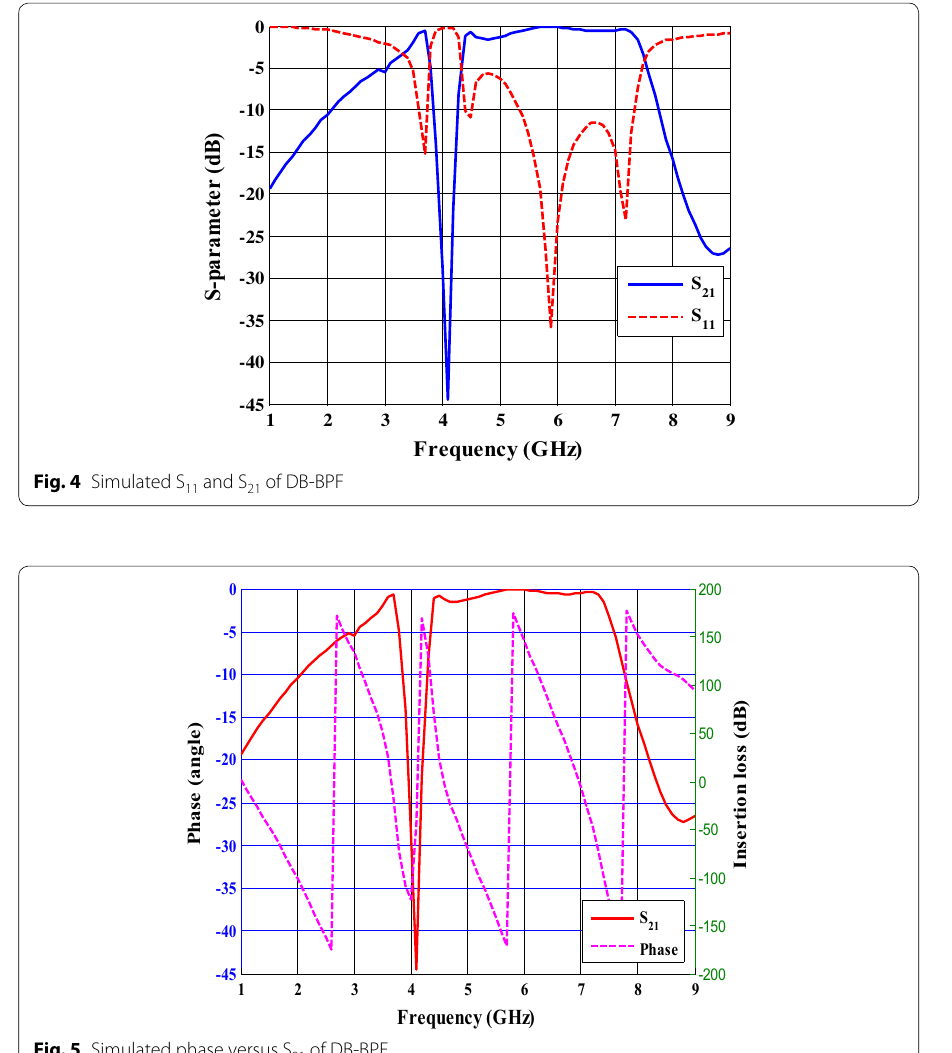
Fig. 5 Simulated phase versus S 21 of